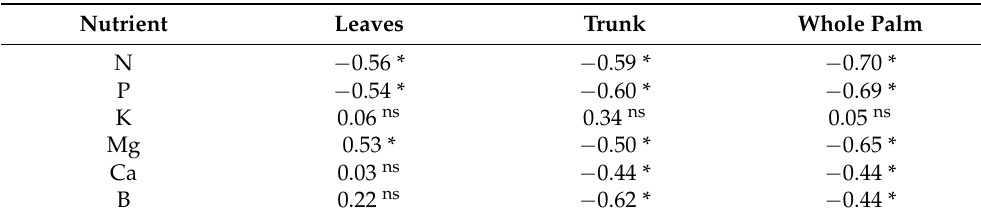
Table 7. Pearson correlations between tissues’ nutrient concentration with palm age in 12-to-238-month-old tenera oil palm. Values presented are correlation coefficients. * p < 0.05; ns p > 0.05.